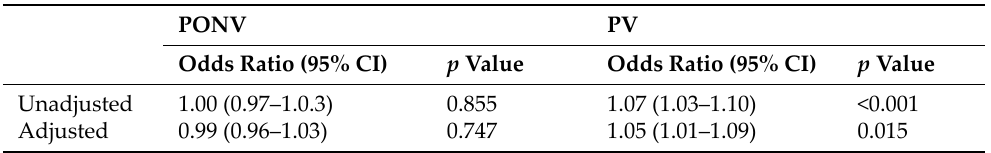
Table 3. Odds ratio of pregnancy duration for developing PONV and PV in pregnant women who underwent nondelivery surgery. PONV PV Odds Ratio (95% CI)